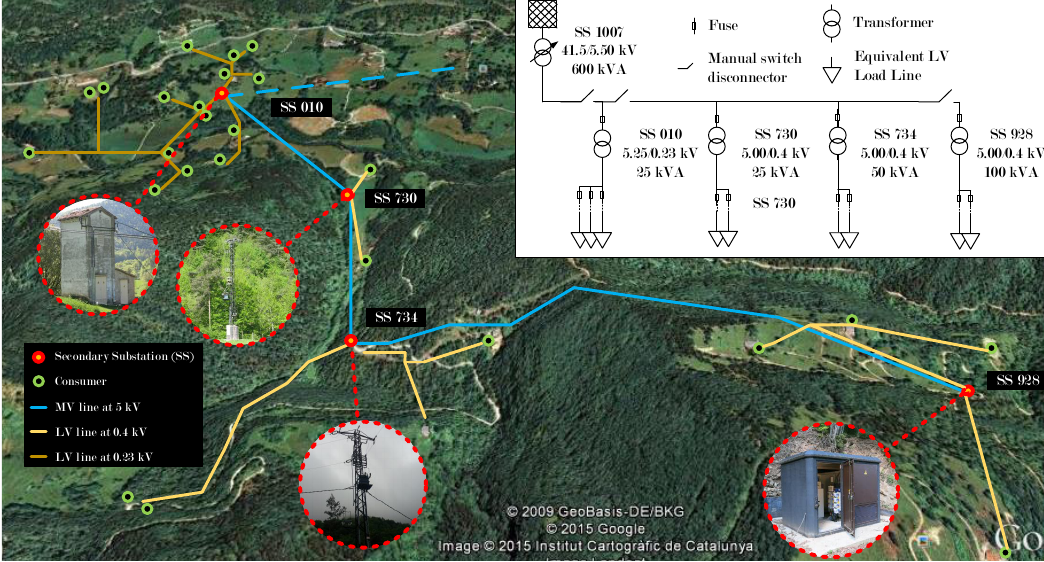
Figure 1. Area from Pilot Network (PN) and its electrical